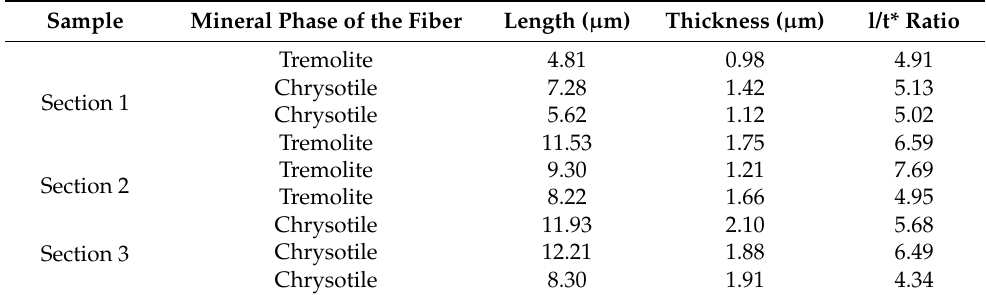
Figure 6. Fiber observed directly in a thin section and the relative EDS analysis. ( a ) Small fiber observed in thin section. ( b ) EDS spectrum collected on the fiber in ( a ) and identifying tremolite. Table 1. Morphological characteristics and mineral phase of the fibers detected in the thin sections (* length/thickness ratio).